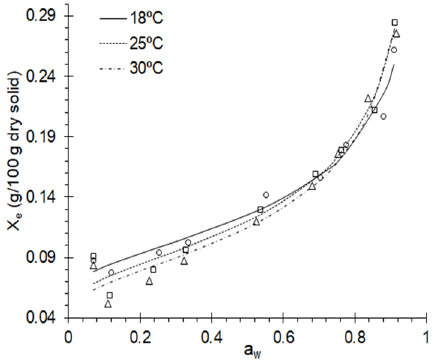
Figure 1. Adsorption isotherms adjusted with the Halsey